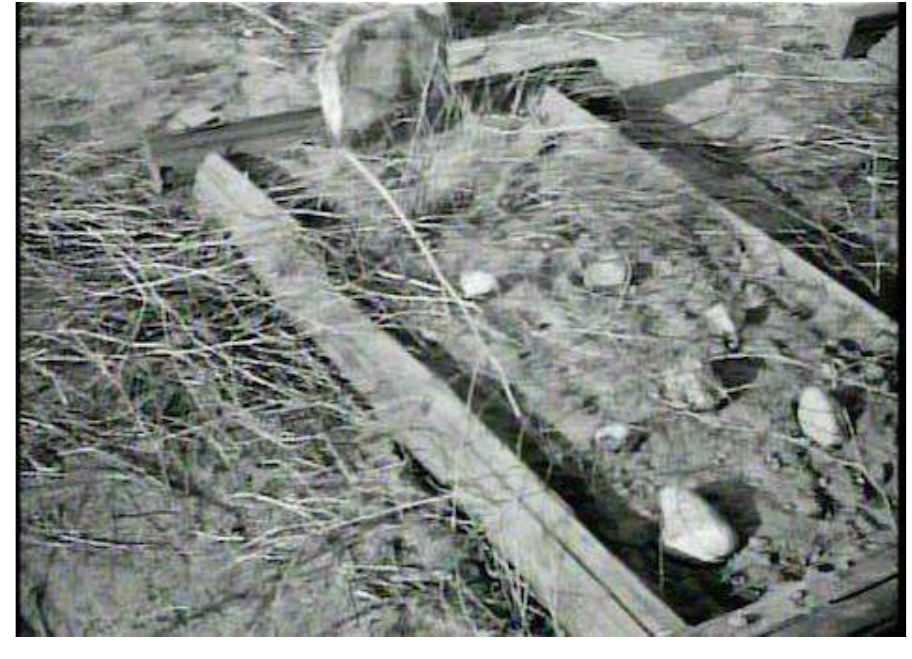
Figure 5: The unnamed graves in